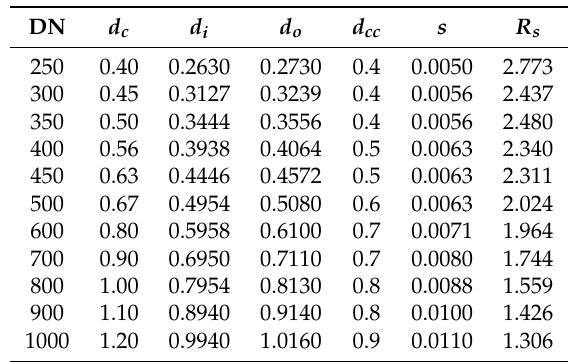
Table A3. Dimensions of compound single pipes and resulting symmetrical thermal resistance. All distances are expressed in m, the thermal resistance per unit length R in Km/W. All data has been retrieved from Isoplus catalogues